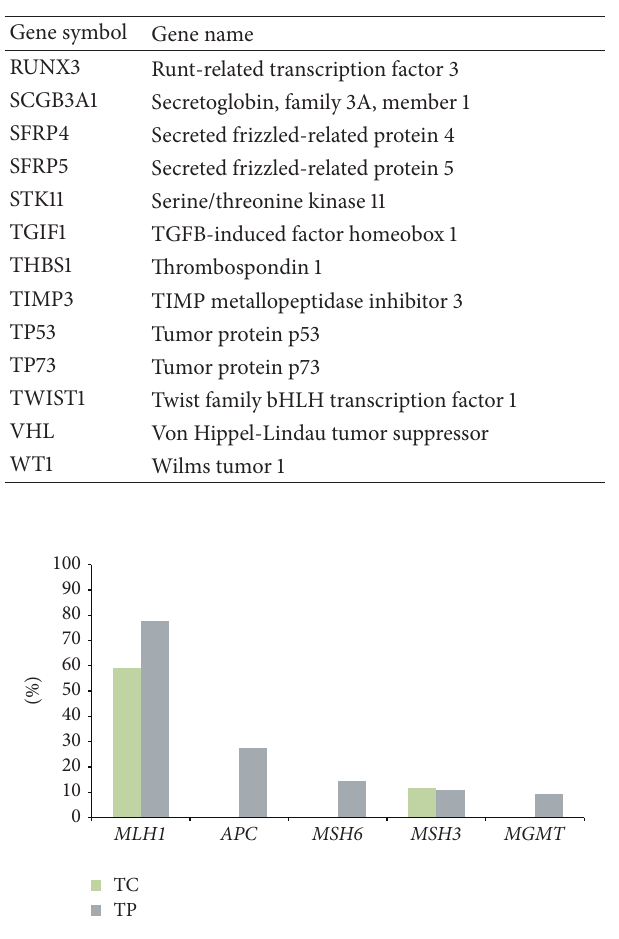
Figure 2: Genes methylated in a gastric leiomyoma. Grey bars represent the genes methylated in the tumor periphery and green bars represent the genes methylated in the tumor